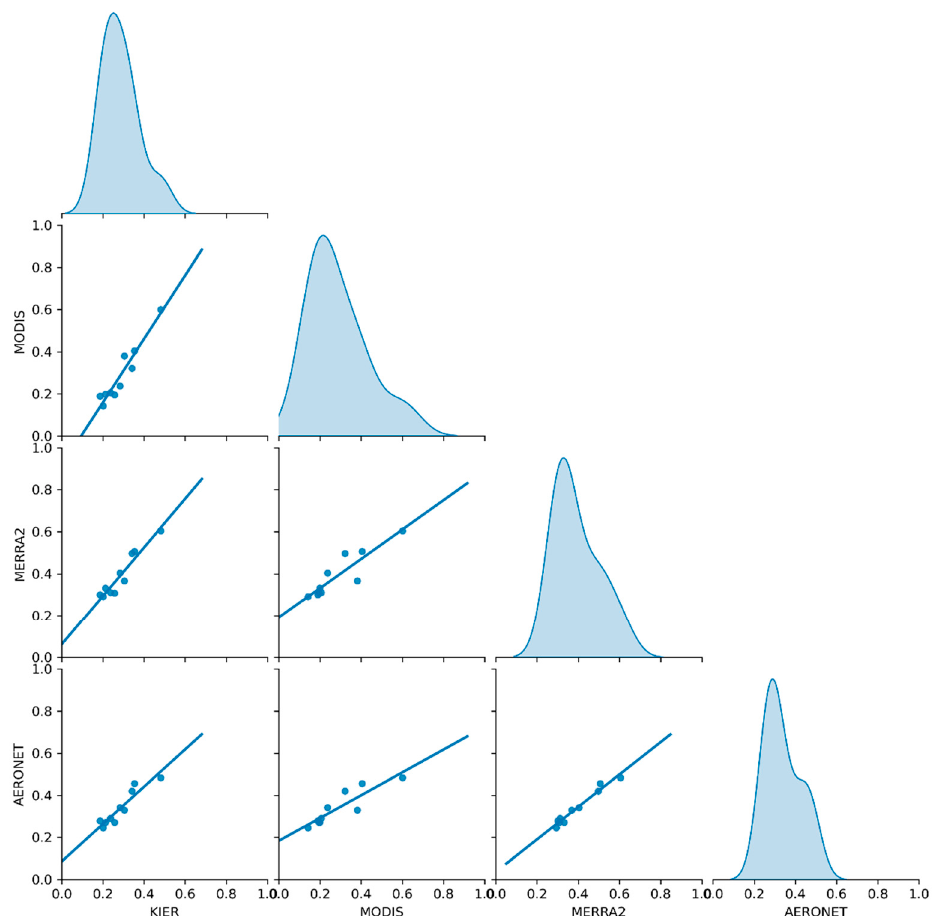
Figure 3. Scatter plot matrix of monthly mean aerosol optical depth between the Aerosol Robotic Network (AERONET) data, POM-02 skyradiometer at the Korea Institute of Energy Research (KIER) station, MODerate resolution Imaging Spectroradiometer (MODIS) products, and Modern-Era Retrospective Analysis for Research and Applications Version 2 (MERRA-2) reanalysis. The relative frequency of aerosol optical depth datasets is also given in each figure.